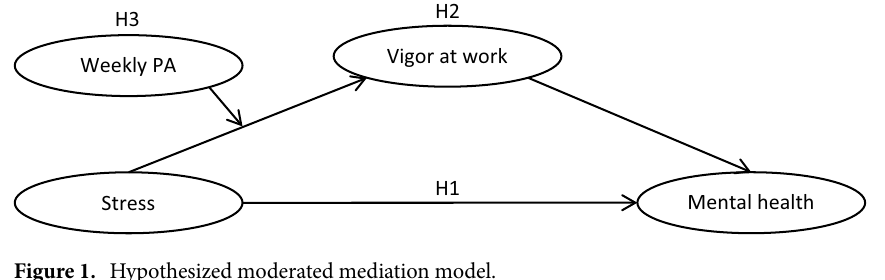
Figure 1. Hypothesized moderated mediation